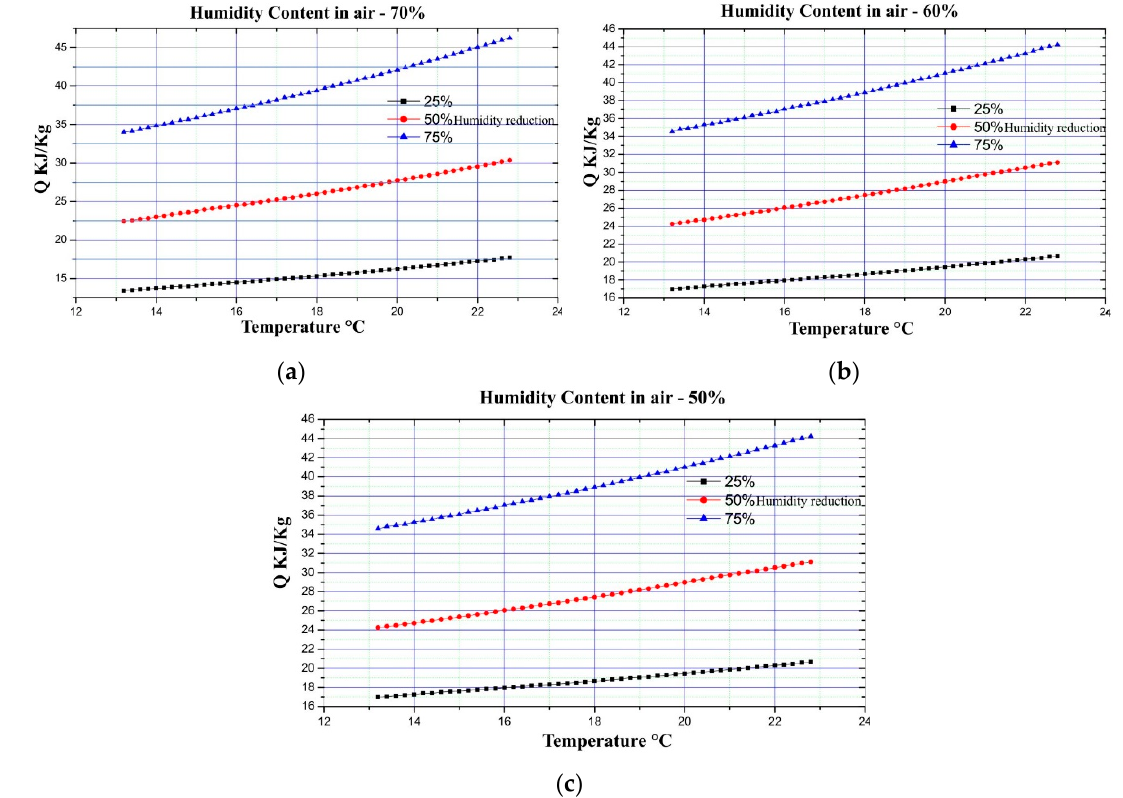
Figure 8. Heat to be removed for the three percent humidity reduction (25%, 50% and 75%) with air humidity content of 50% ( c ), 60% ( b ), and 70% ( a ).